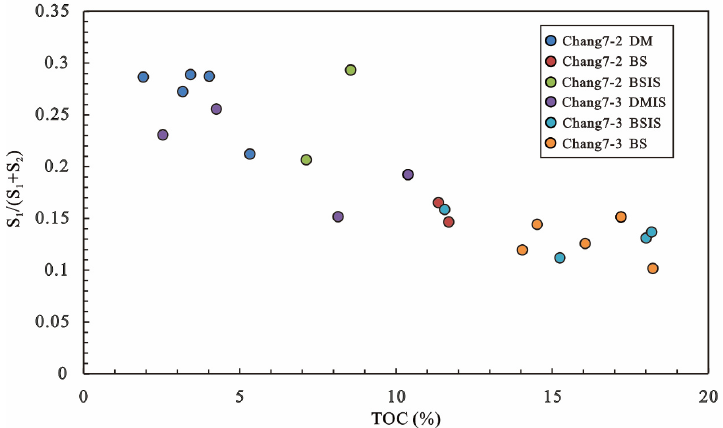
Figure 13. Plot of production index (S 1 /S 1 + S 2 ) versus TOC content. The high production index in sandstones with a low TOC content is a result of migrated oil.